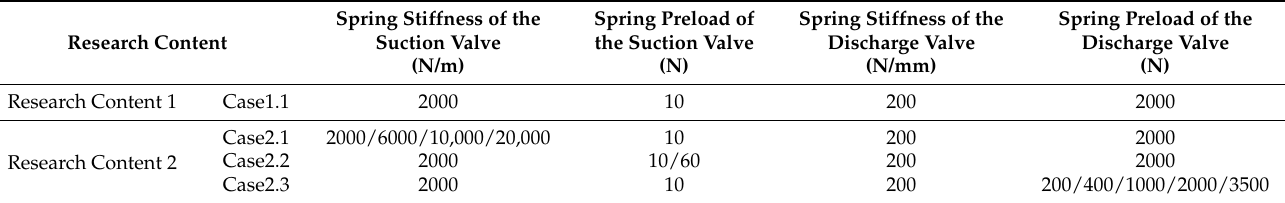
Table 2. Valve spring parameter